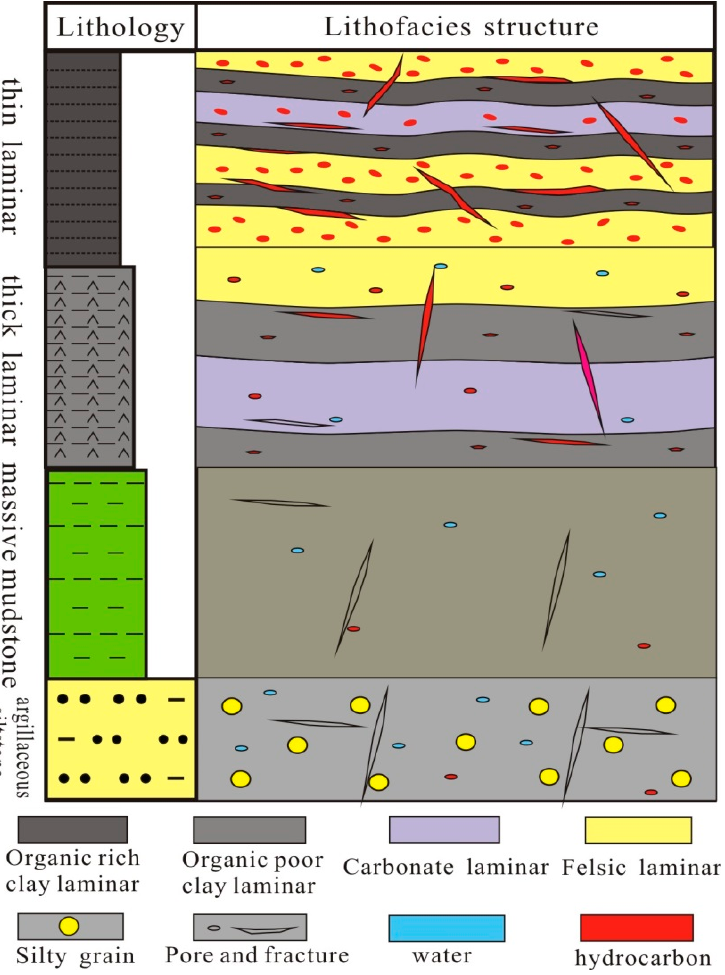
Figure 13. Shale oil enrichment mode of different lithofacies in Es3 formation.